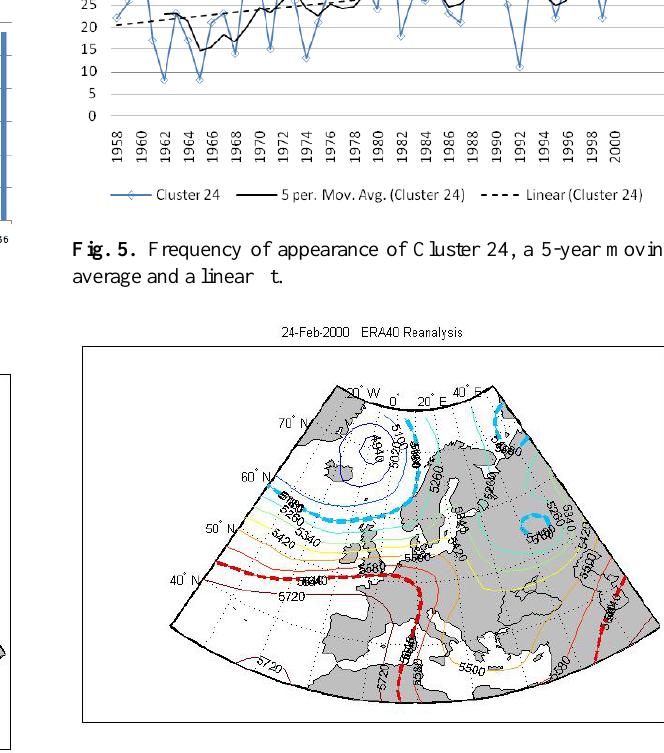
Fig. 6. Typical pattern of Cluster 1: 24 March 2000 (units: Fig.6. Typical pattern of Cluster 1: 24 March 2000 (units: gpm).